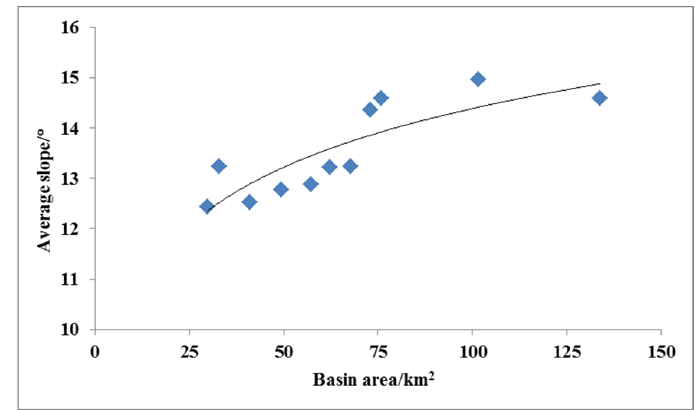
Figure 4. Average slope varying with basin area.